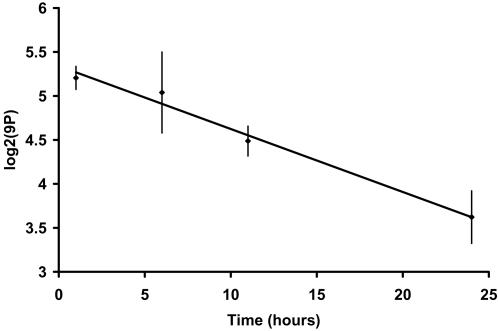
Loss rate of applied 9-C25∶1 in LD.Compound was applied at time 0 (see Methods) and measured on groups of 5 flies at times 1, 6, 11 and 24. Vertical axis shows log2(yt/yn), where yt is concentration at time t in perfumed flies and yn is daily mean concentration in non-perfumed flies. R2 = .9837, slope = .0716, implied loss rate per day is 329%. Proportional loss rate is constant over time.